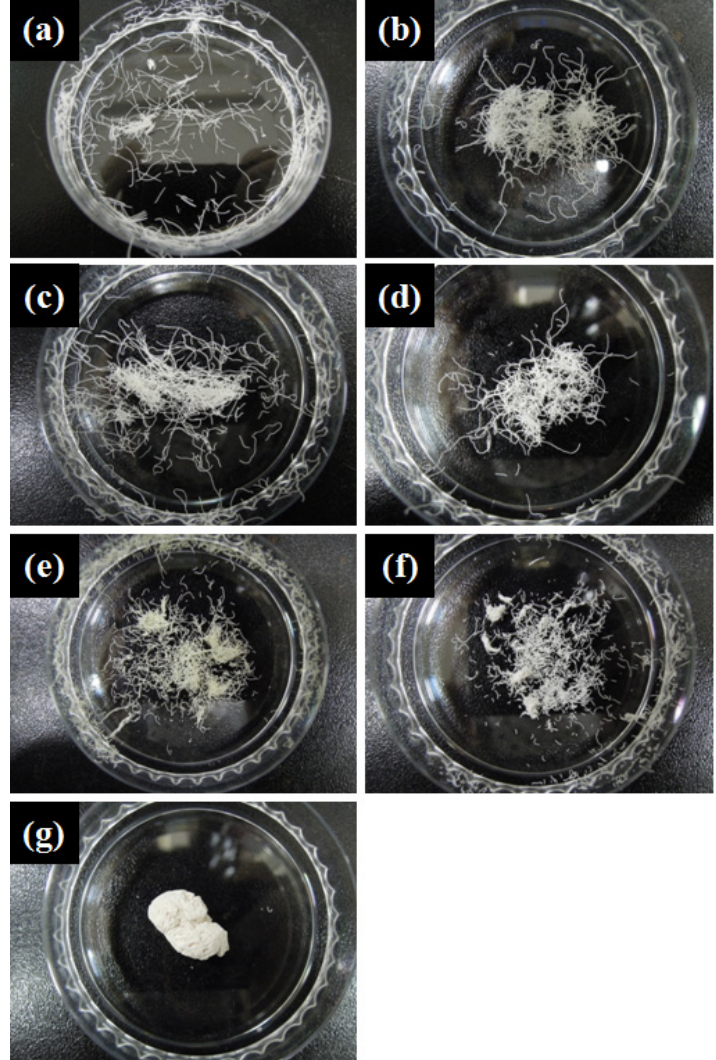
Figure 1. Photographs of the polyacrylonitrile (PAN)–oxime fibers prepared at different reaction times. ( a ) 0 min; ( b ) 5 min; ( c ) 10 min; ( d ) 15 min; ( e ) 20 min; ( f ) 25 min; and ( g ) 30 min.